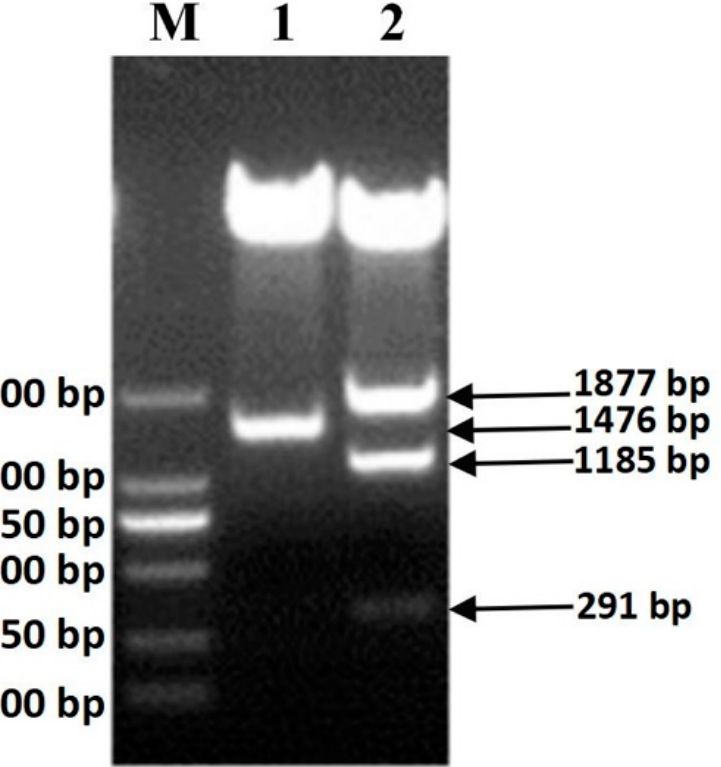
Figure 1. Construction of the endosperm-specific plant expression vector PTF101.1-GT1- AtAAP1 based on triparental hybridization method. Lane M represents the DL2000 DNA marker. Lane 1 represents from the double digestion of PTF101.1-GT1- AtAAP1 by Sma I and Sac I. Lane 2 represents the GT1 promoter sequence (1877 bp)